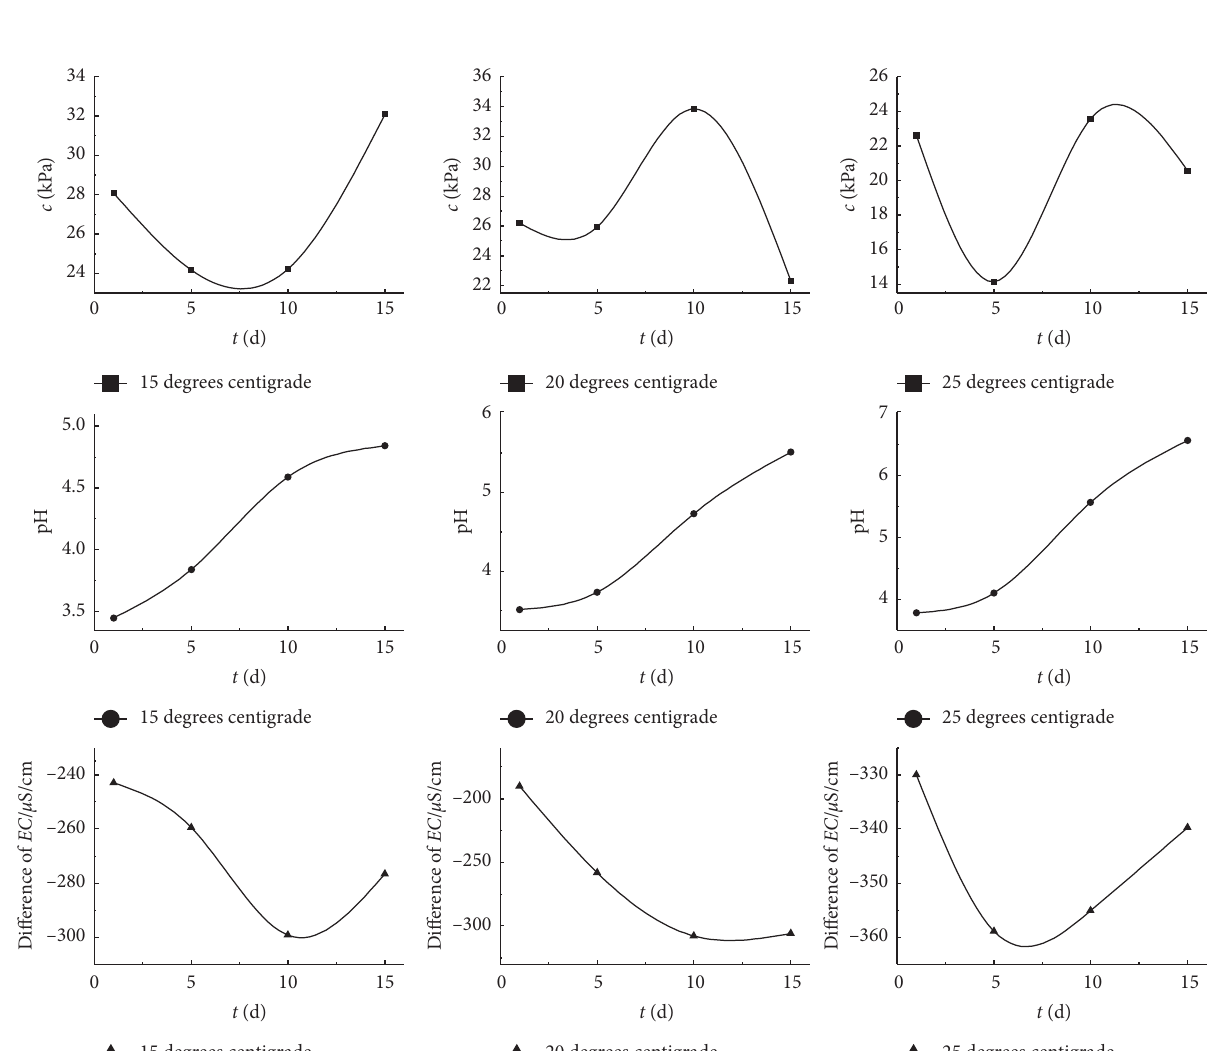
Figure 1: Variable characteristics of the soaking liquid parameters and cohesive force (HNO